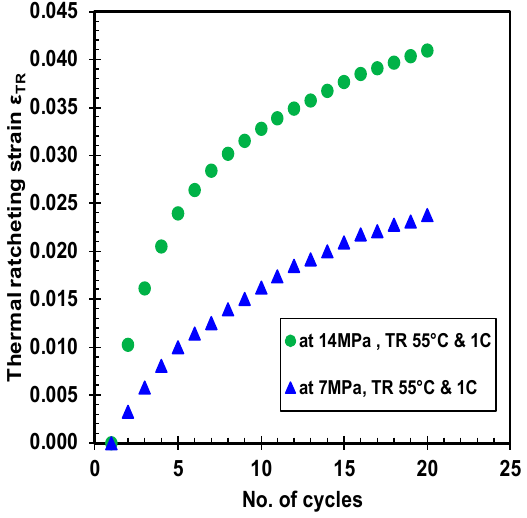
Figure 11. Thermal ratcheting strain at different applied loads.